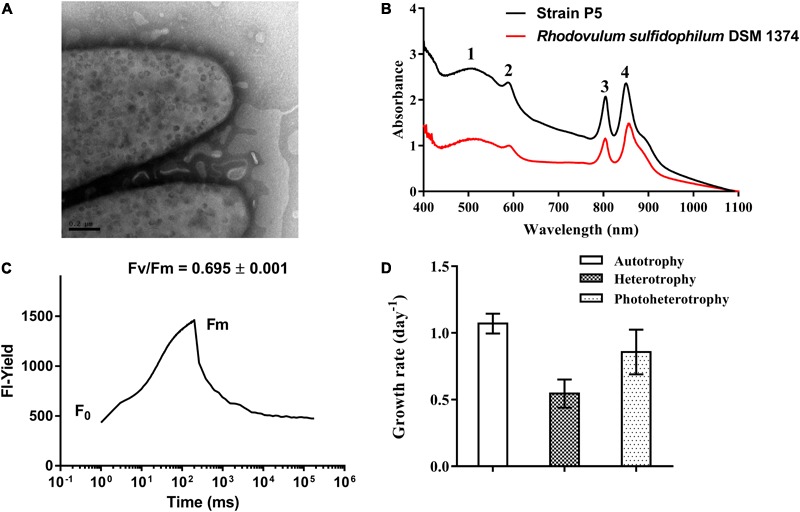
Morphological, biochemical and physiological characterization of bacterial strain P5. (A) Transmission electron micrograph images of strain P5. The external surface of the cytoplasmic membrane of strain P5 is of vesicle type. (B)
In vivo absorption spectrum of strains P5 and reference strain. (C) Fluorescence induction and relaxation kinetics recorded by infrared fluorometry. (D) Growth rates of bacteria.